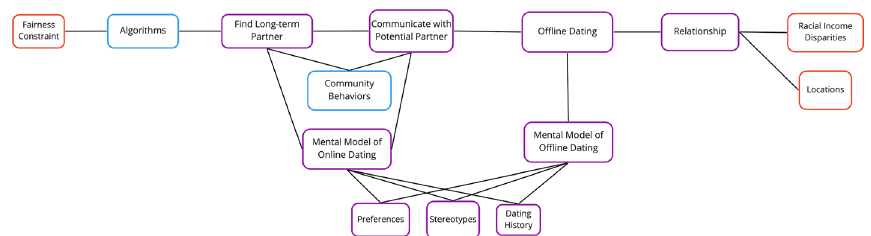
Fig. 3 All paths in the undirected network of length less than eight that move only through general functions and physical functions/forms, from Fairness Constraint to the two inequality physical form